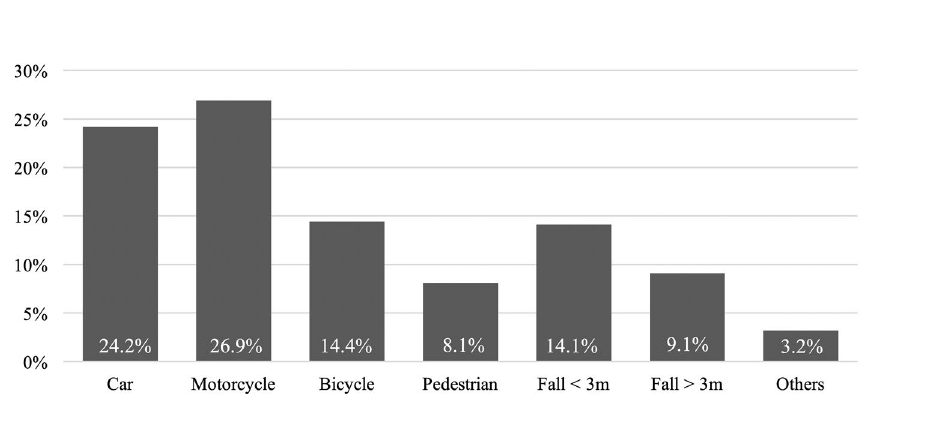
Figure 2. Trauma mechanism.